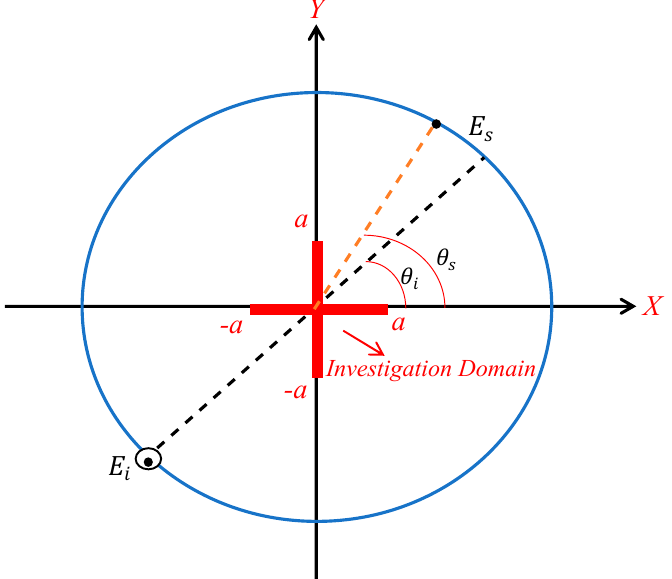
Figure 11. The geometry of the cross-strip ID.